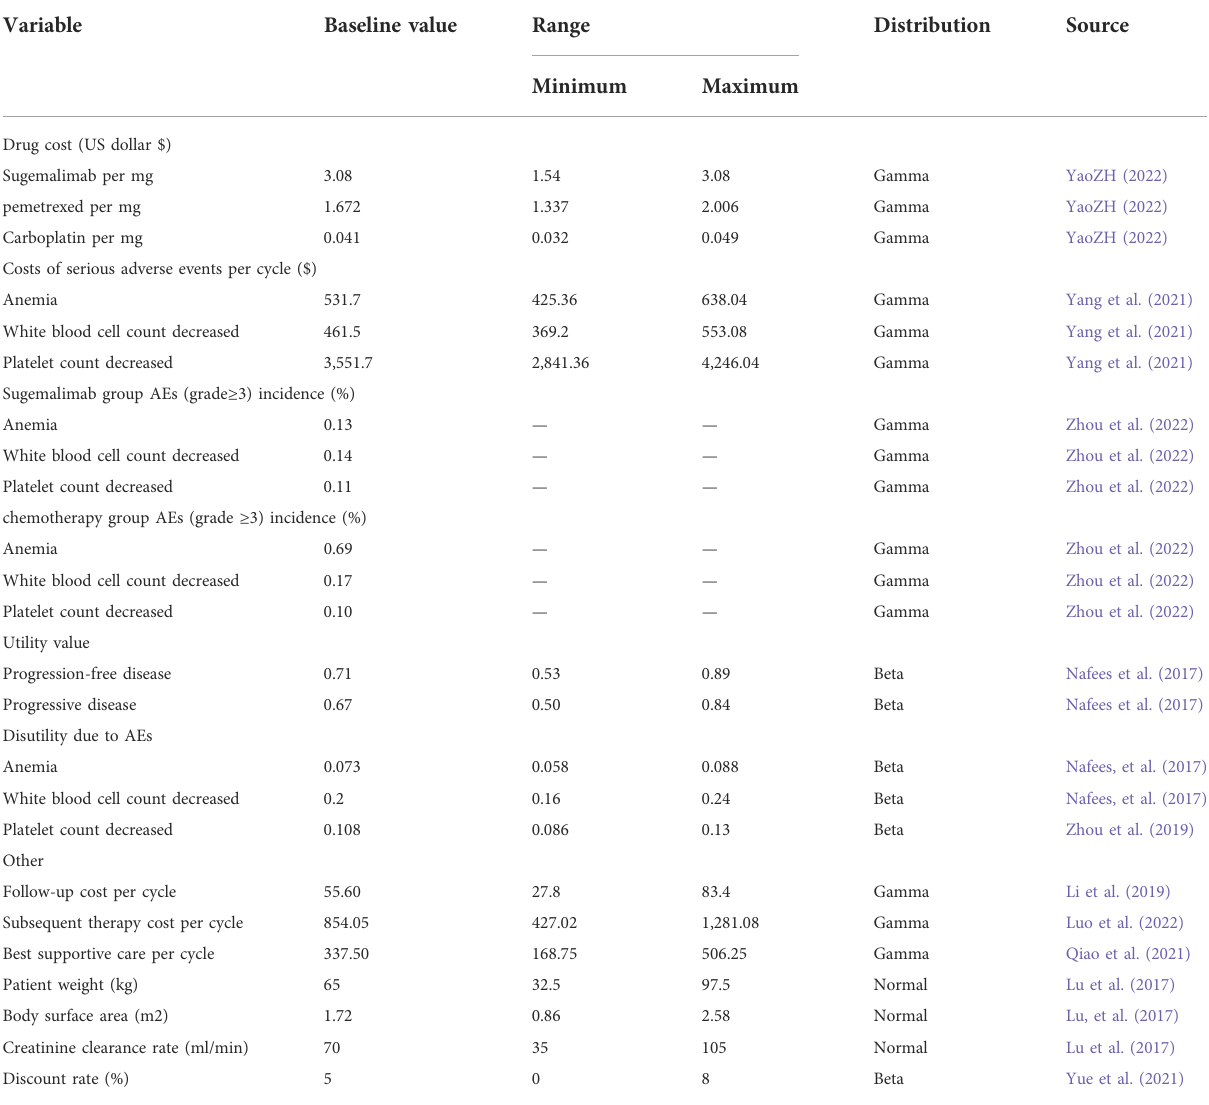
TABLE 2 Model economic parameters and the range of the sensitivity